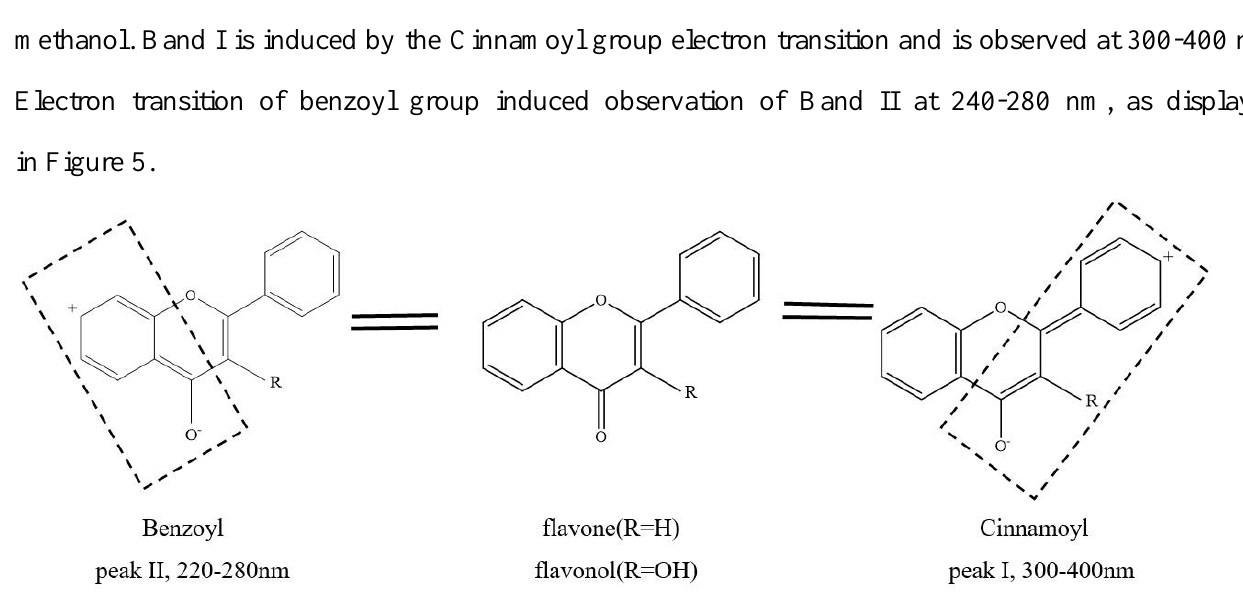
Figure 5. Absorption bands of Flavonoids in the UV